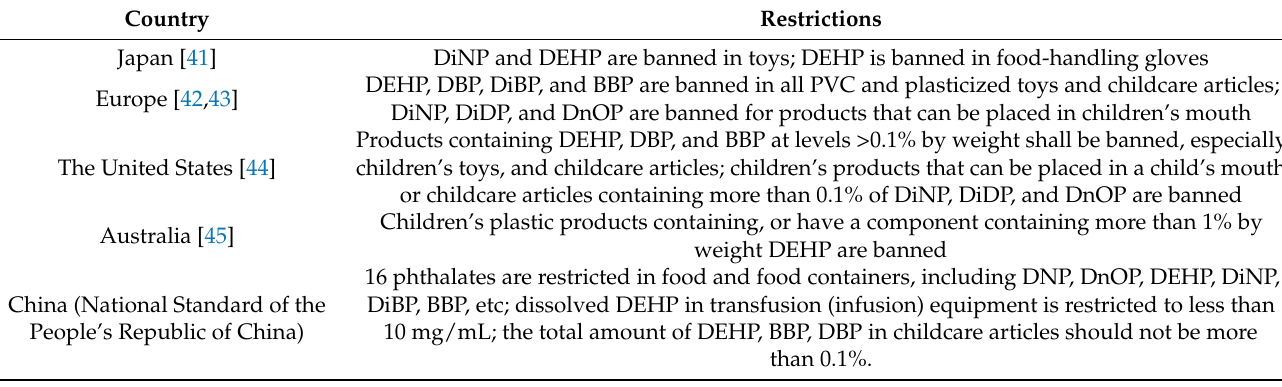
Table 3. Restrictions in Japan, Europe, the US, Australia, and